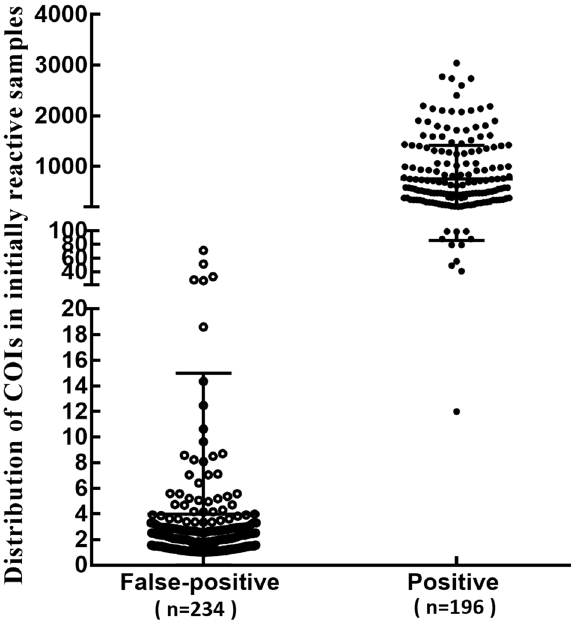
Figure 1. Distribution of screening values of COIs in false-positive and positive specimens.